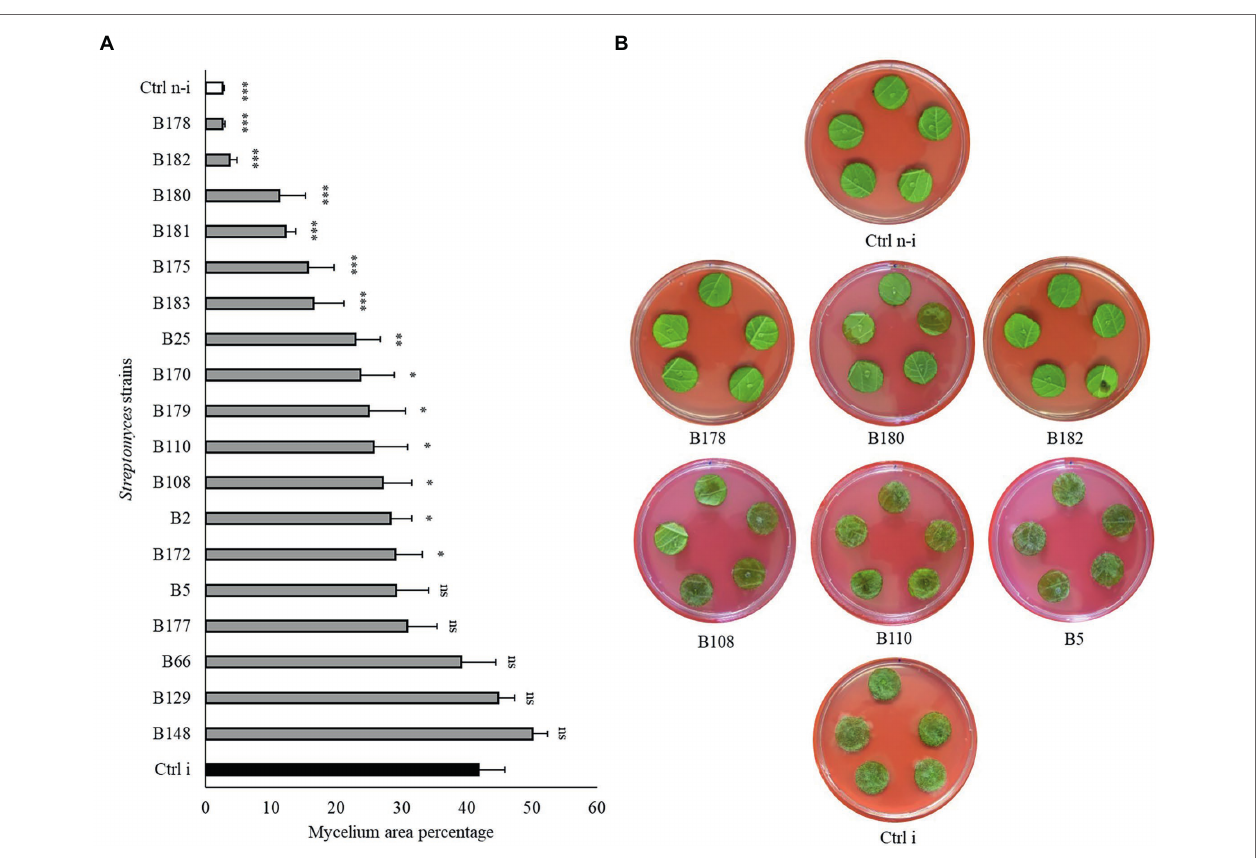
FIGURE 4 | Leaf disc assay of Streptomyces strains against Phytophthora infestans . (A) Bar chart showing average mycelium growth area percentage (measured by Image J). Bars are averages of 15 leaf discs from two independent experiments with standard errors. Asterisks represent statistically significant differences in comparison to the non-treated, infected control ( *** p < 0.001, ** p < 0.01, and * p < 0.05). (B) Representative pictures of the leaf discs from the non-treated, infected (Ctrl i) and non-infected controls (Ctrl n-i), as well as from strains showing different levels of disease inhibition. Pictures were taken 5 days after